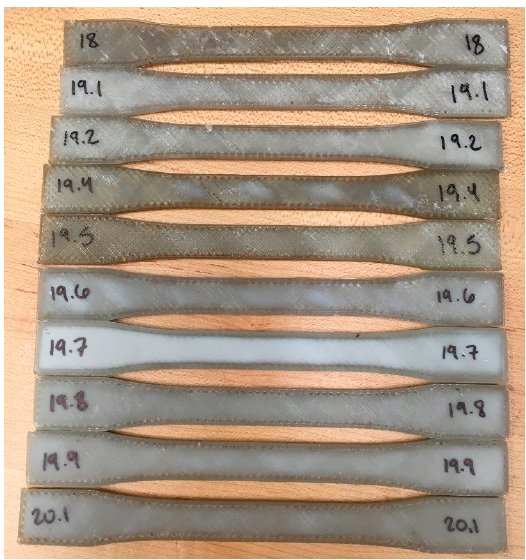
Figure 11. Tensile bars 3D printed with rPET water bottle flake on the adapted Gigabot X and Crammer shown in Figure 2.